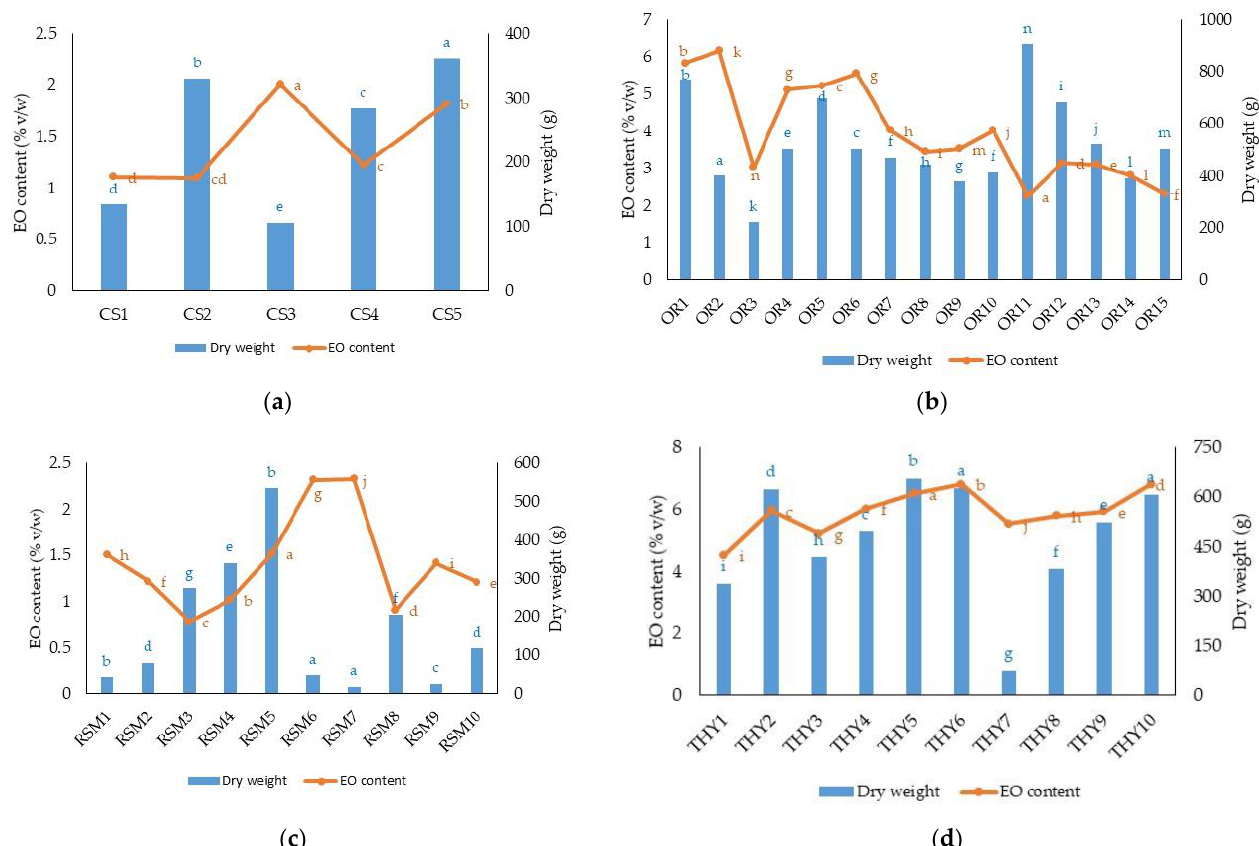
Figure 2 . Ratio between essential oils (EO) content and plant dry weight. Means followed by the same letter in the same column are not significantly different for p ≤ 0.05 according to test of Tukey . Graph ( a ) refers to common sage, graph ( b ) refers to oregano, graph ( c ) refers to rosemary and graph ( d ) refers to thyme.